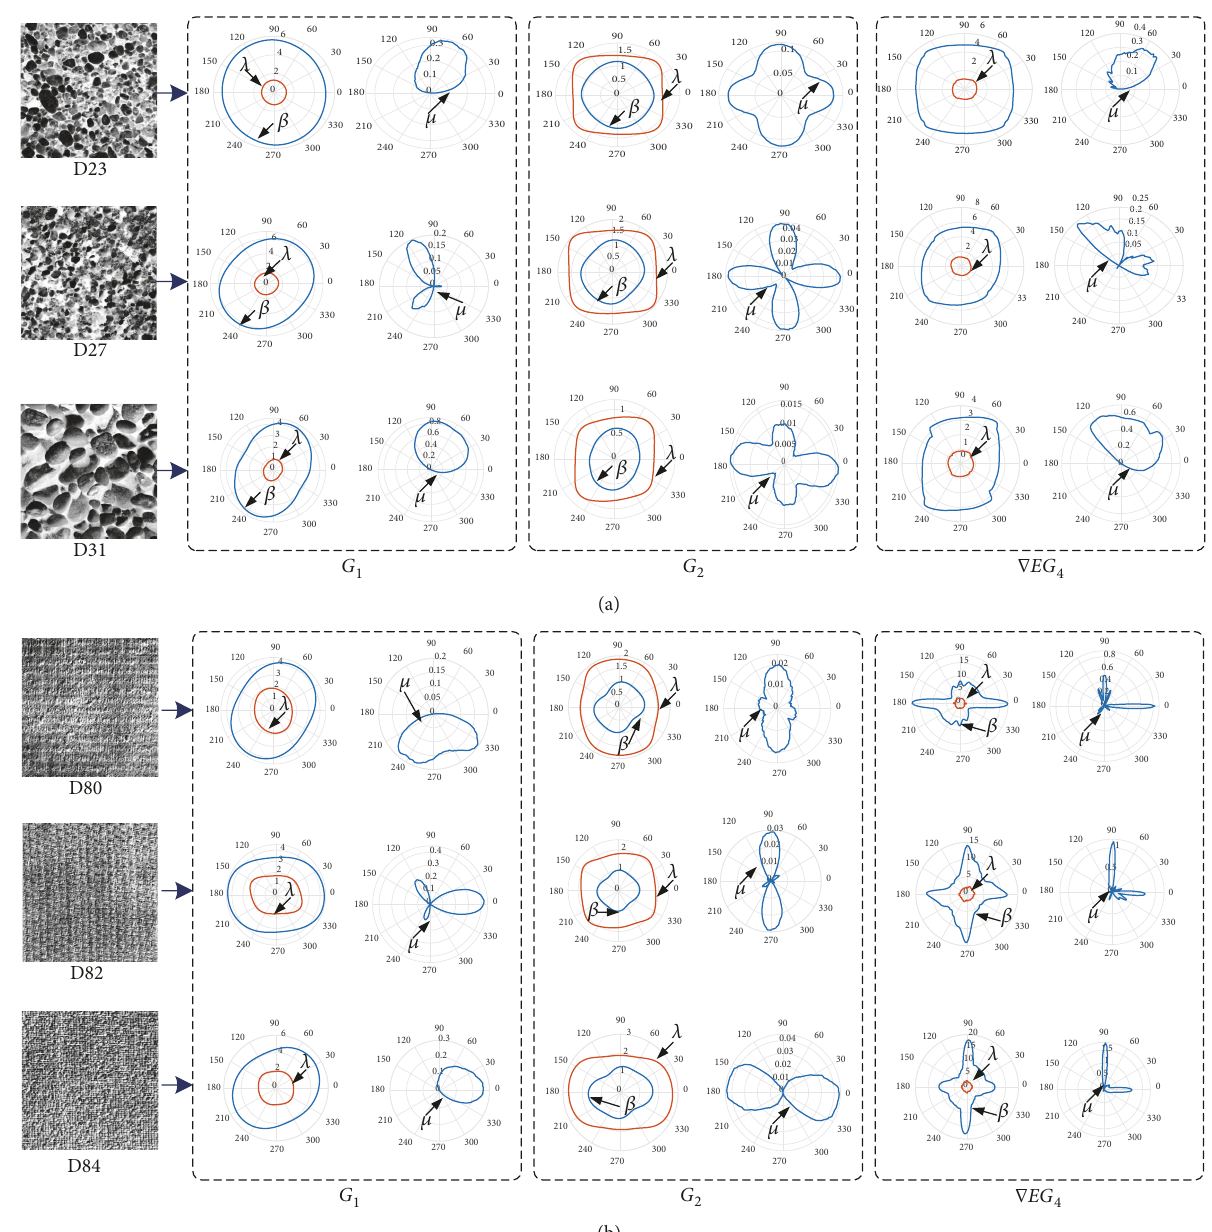
Figure 14: SWDM feature comparison of two groups of confusing TPs in Brodatz database, whose distinctive texture pattern characteristics can be expressed by the SWDM parameters 𝜆,𝛽, 𝜇 . (a) Rubble-like TPs, D23, D27, and D31. (b) Different TPs with great surface resemblance, D80, D82, and